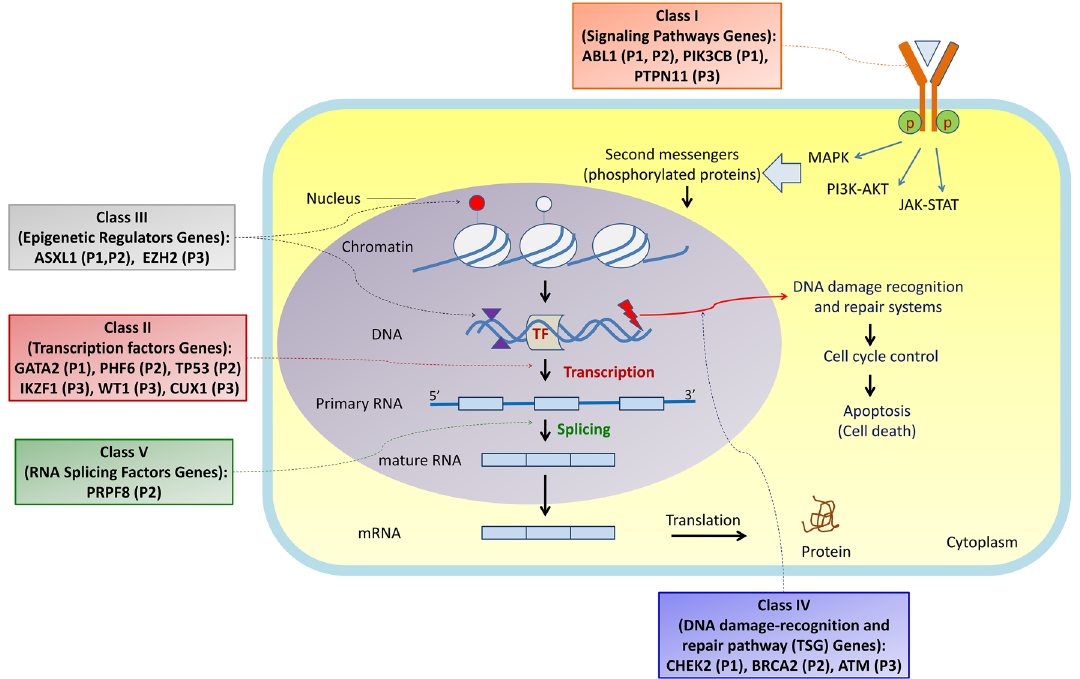
Figure 4. The detected SNV and Indel variants in WES related to leukemogenic gene classes. The classes of leukemogenic genes includ signaling pathway genes (class I), transcription factors (class II),